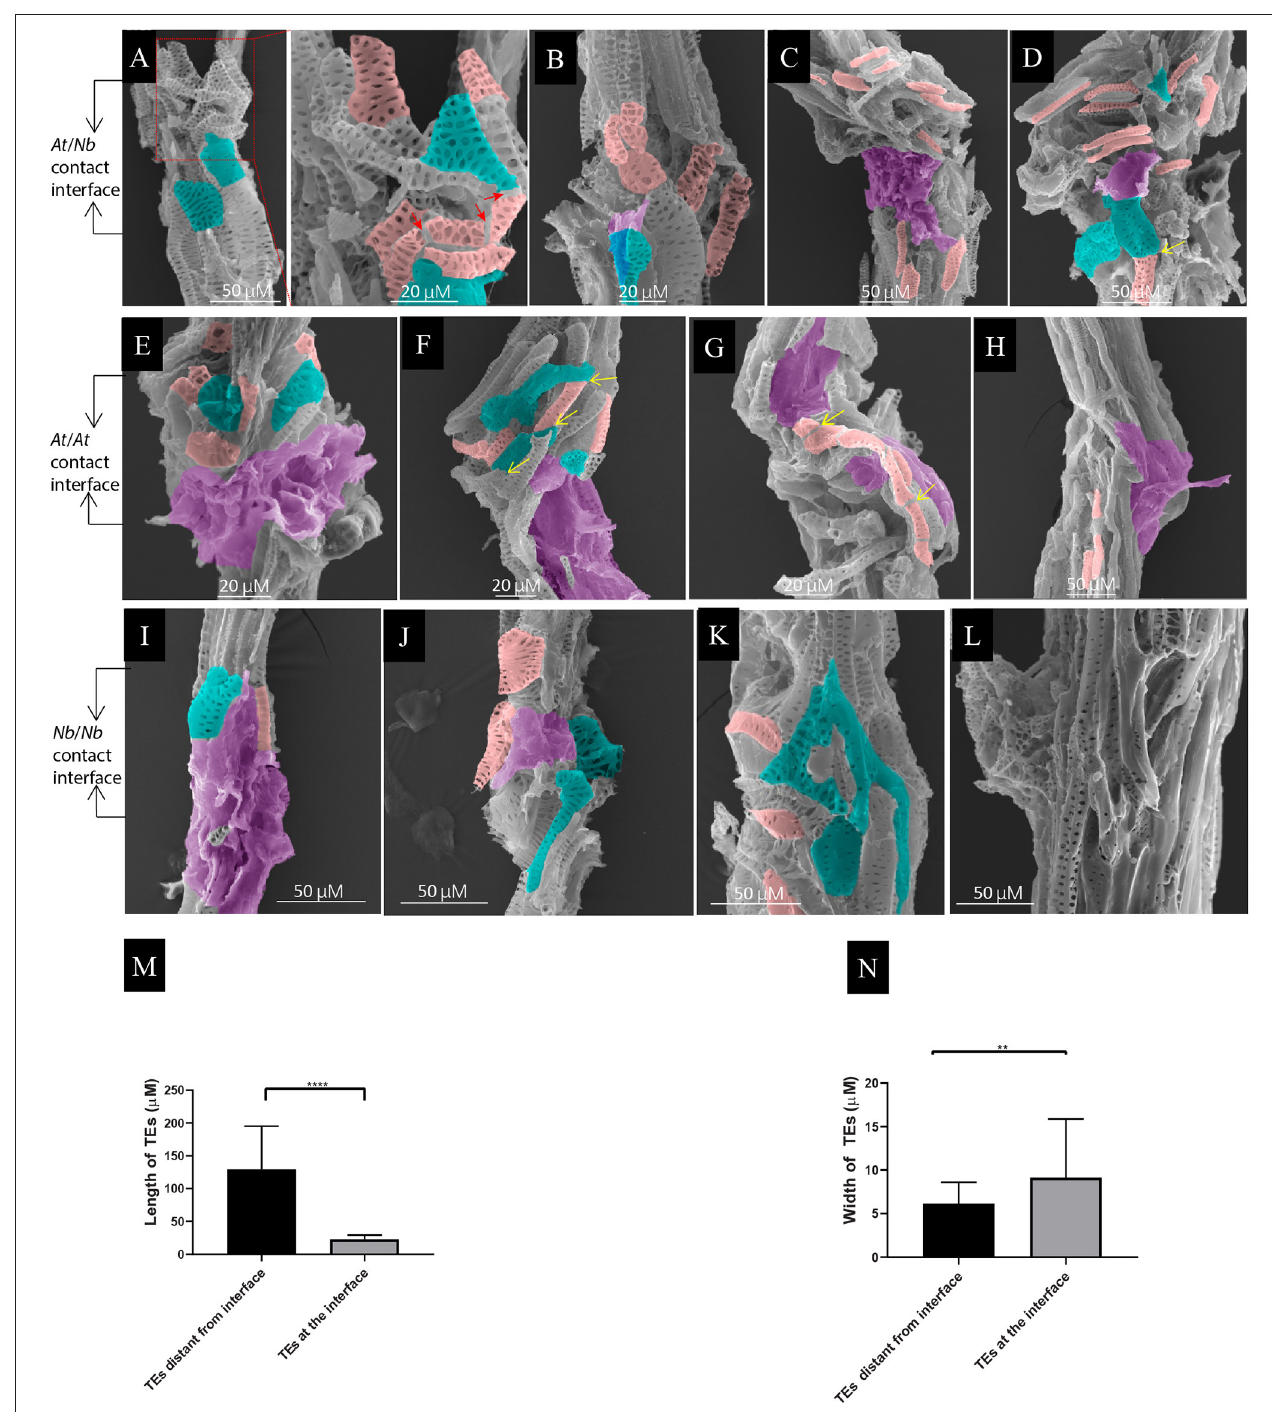
FIGURE 3 | Local TE segmentation and cellular deposits on the TEs during graft union formation. (A) At / Nb graft union at 7 DAG. The shape of some segmented TEs became irregular. Noted that the TEs from At became widened, and the end became attenuated. The red arrows indicated the cracks from a single TE. (B) At / Nb graft union at 9 DAG. Noticed that the deposit of membrane-like patches on the TEs occurred at this stage. (C) At / Nb graft union at 14 DAG. More small, short TEs accumulated at the interface, and larger membrane-like patches covered the interface. (D) At / Nb graft union at 21 DAG. Short TEs further accumulated at the interface, and some of them began to fuse indicated by the yellow arrows. (E) At self-graft union at 7 DAG. Small segmented and deformed TEs accumulated at the interface, and the whole interface was covered by the cellular deposits. (F) At / At graft union at 9 DAG. Noticed the head-to-head fusion and overlapping between TEs indicated by the yellow arrow. (G) At self-graft union at 14 DAG. Short TEs were accumulated around the union. Noticed that a single longer TE consisting of fused